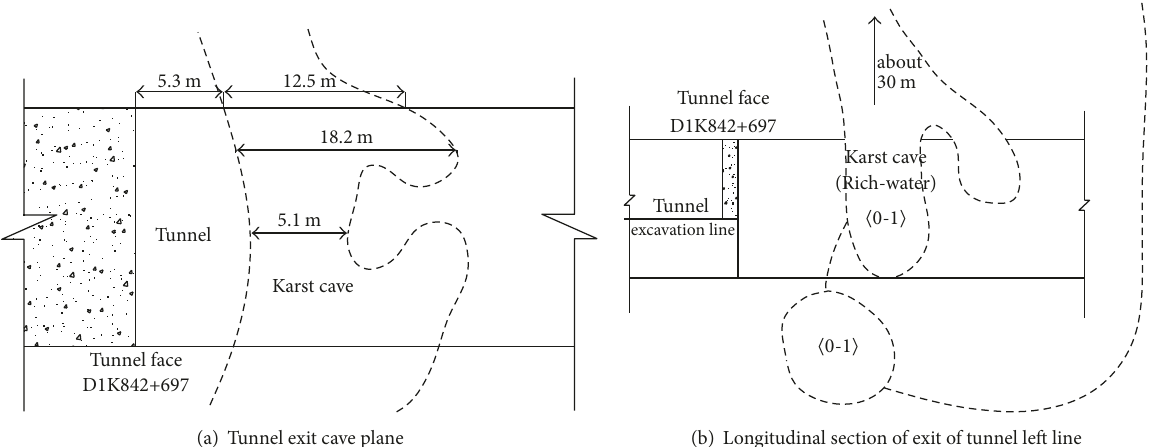
Figure 3: Schematic diagram of cavity at the tunnel exit.